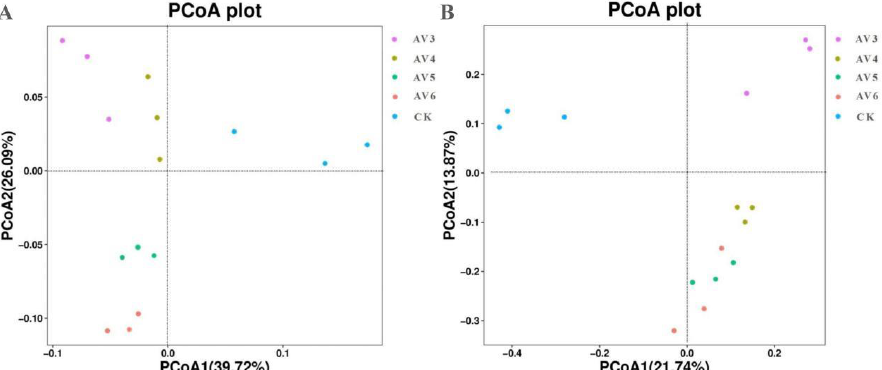
Figure 4. Principal coordinate analysis (PCoA) of the bacterial and fungal communities. ( A ) Results of the PCoA of the bacterial communities. ( B ) Results of the PCoA of the fungal communities. AV3, AV4, AV5, and AV6 represent the rhizosphere soil samples from the fields in which A. villosum was continuously cropped for 3, 4, 5, and 6 years, respectively, whereas CK represents the soil sample from the fallow field.